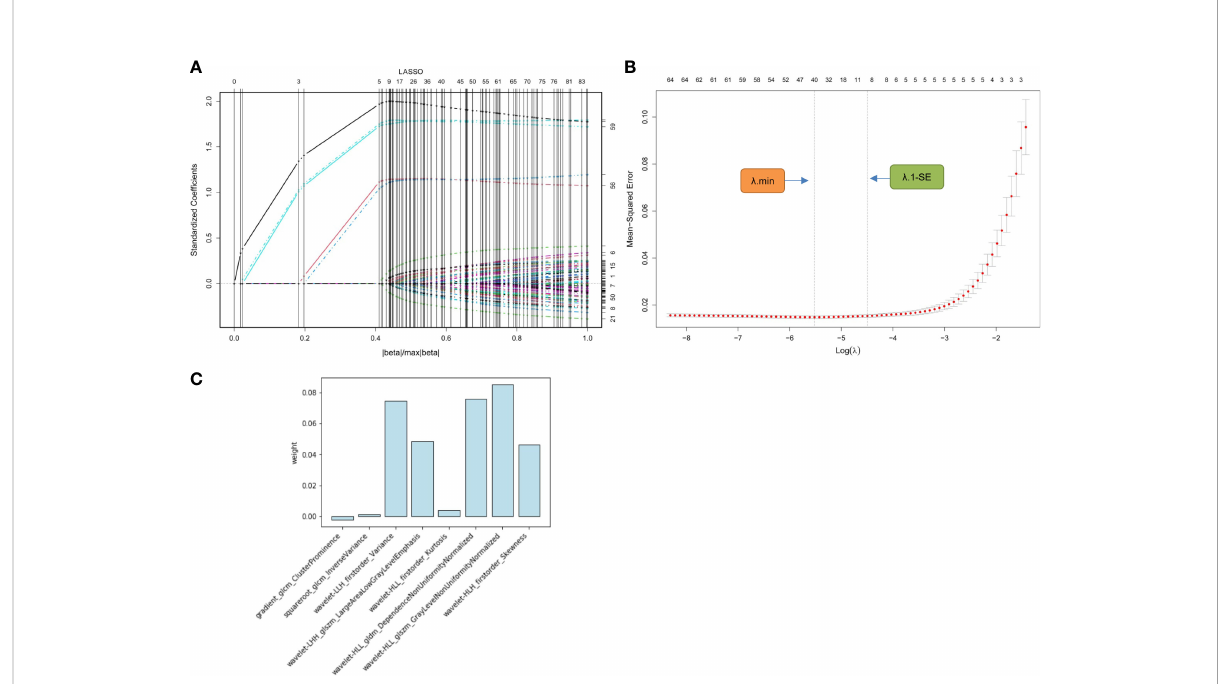
FIGURE 3 Radiomics feature selection using LASSO regression model. (A) Displays the LASSO coef fi cient pro fi les of the 85 radiomics features. (B) Shows the tuning l selection in the LASSO regression. Two dotted vertical lines were plotted at the optimal l values based on the minimum criteria ( l .min) and the 1-standard error for the minimum criteria ( l .1-SE), where the optimal l resulted in 8 nonzero coef fi cients. (C) Lists the weights of the selected radiomics features. LASSO, least absolute shrinkage and selection operator; l , penalty regularization